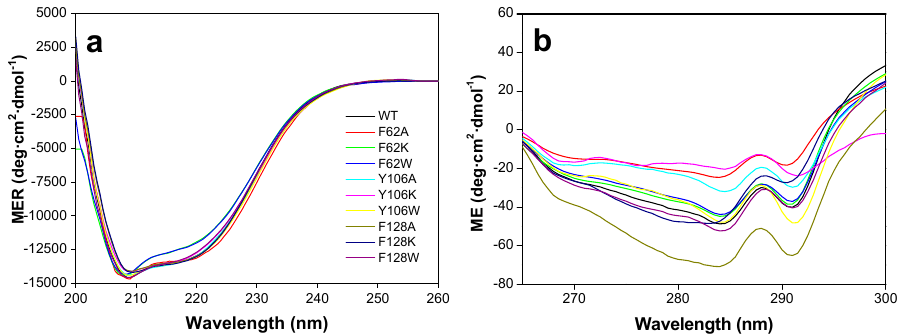
Figure 3. Conformation of Ca FADS variants. CD spectra ( a ) in the far-UV region (molar ellipticity per residue) and ( b ) in the near-UV region (molar ellipticity) for the different Ca FADS variants. Spectra were recorded respectively in 5 mM and 20 mM PIPES, 10 mM MgCl 2 , pH 7.0 at 25 °C.